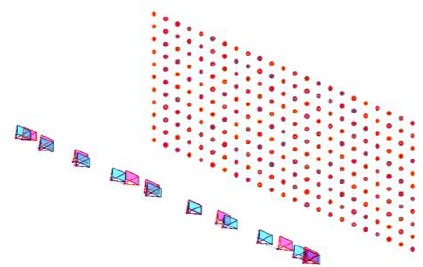
Figure 10 Original cameras (cyan) and optimal cameras (magenta) for fixed rotation optimisation